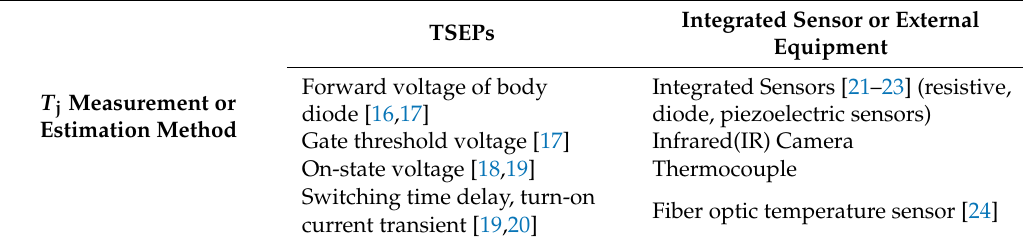
Table 1. Junction temperature measurements and